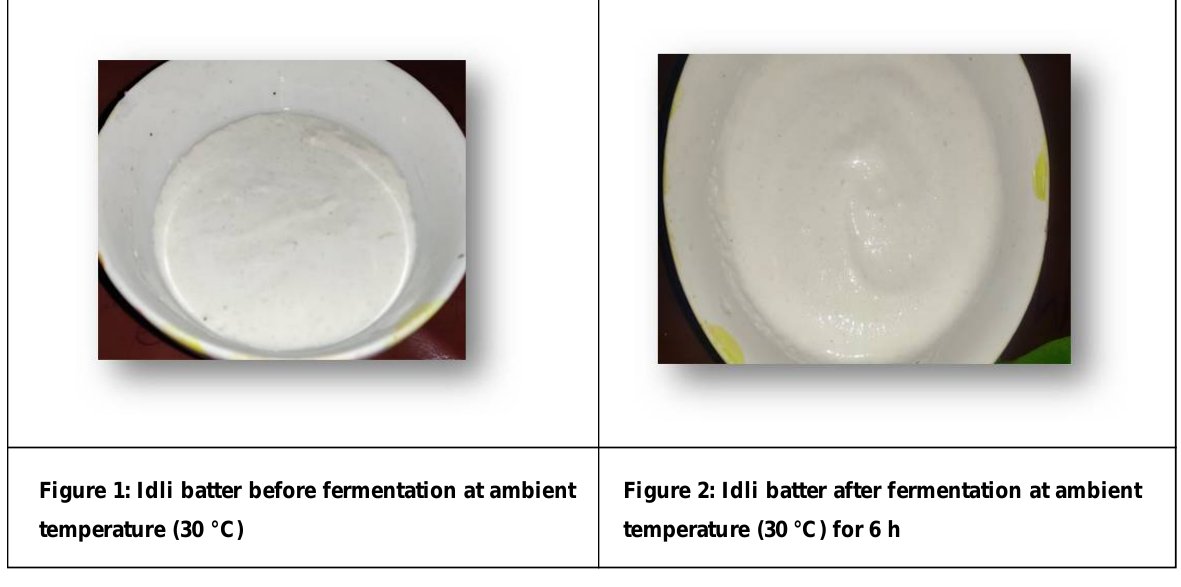
Figure 1: Idli batter before fermentation at ambient temperature (30 °C)